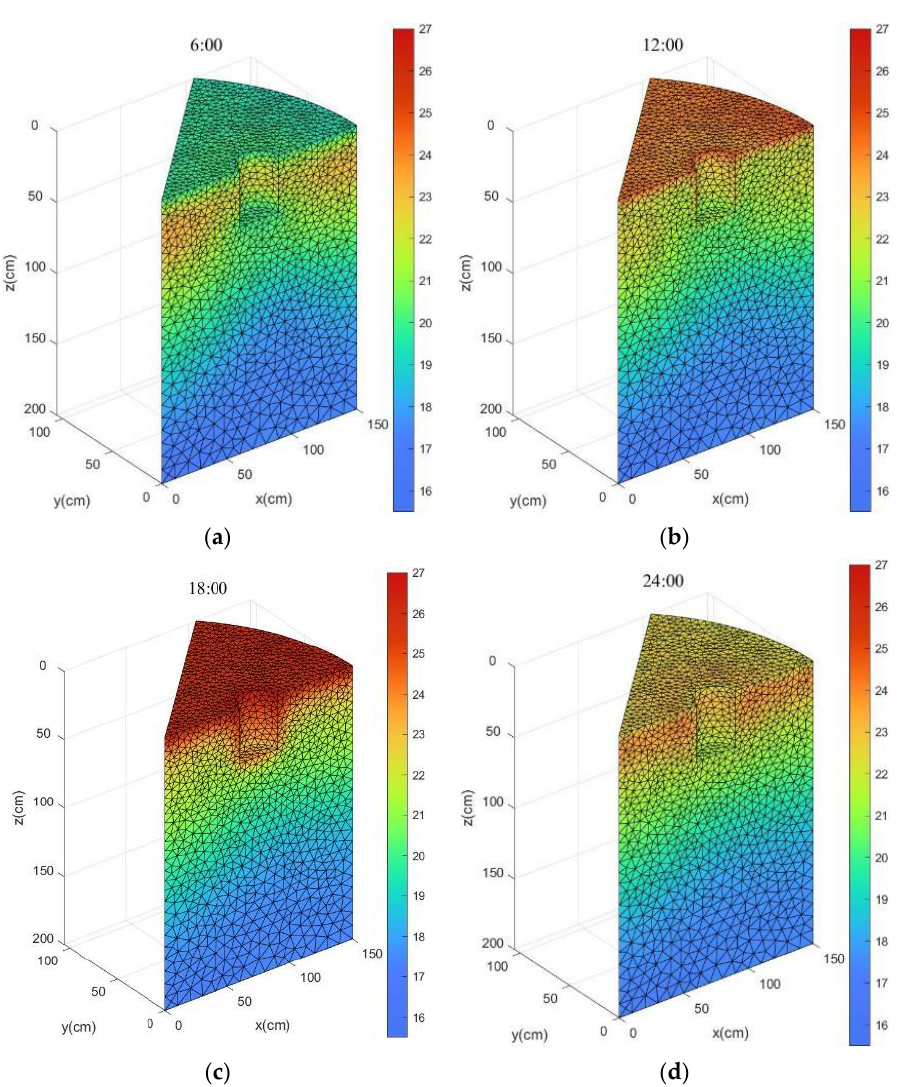
Figure 12. Simulation of soil temperature distribution at different times after 1 day of irrigation. ( a ) 6:00 soil temperature; ( b ) 12:00 soil temperature; ( c ) 18:00 soil temperature; ( d ) 24:00 soil temperature. Table 9. Calculation of the statistical indexes of soil temperature for water storage pit irrigation day. Parameters